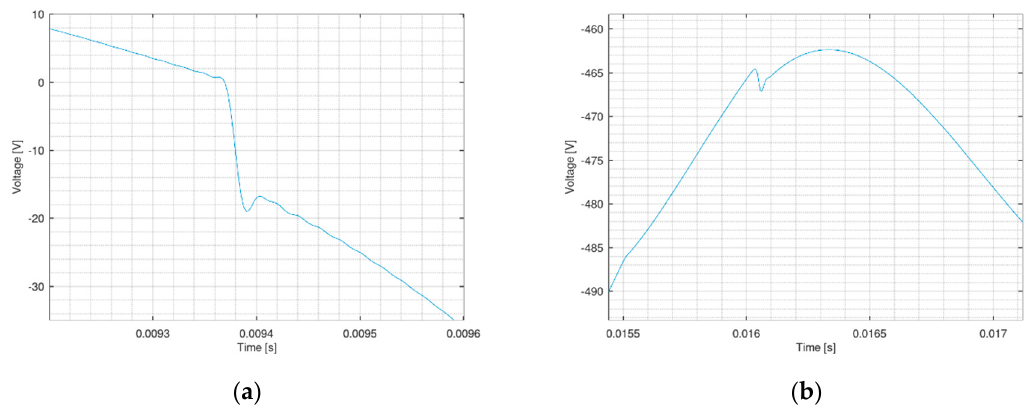
Figure 13. Voltage across the nonlinear element in the time domain—Gibbs effect: ( a ) Detail 1; ( b ) Detail 2.